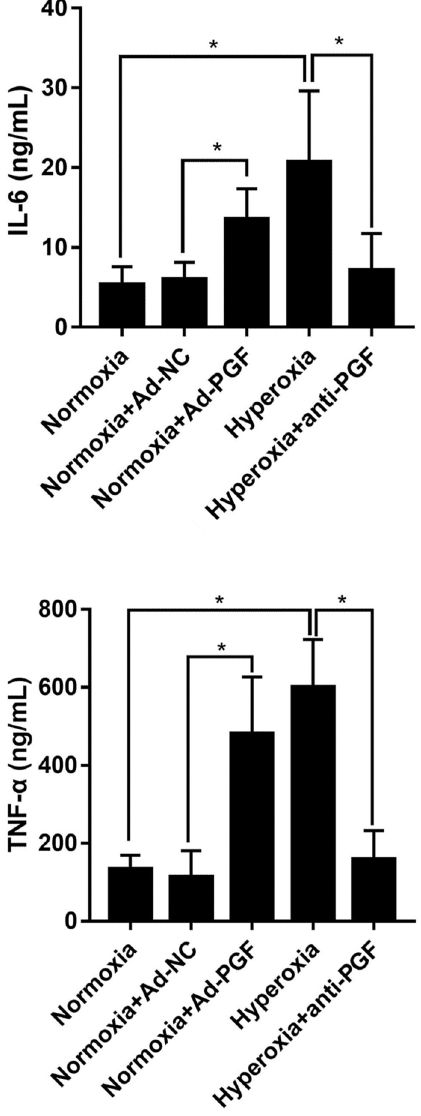
Figure 6. Interleukin (IL)-6 and tumor necrosis factor (TNF)- a levels in bronchoalveolar lavage fl uid from newborn rats of each indicated group (n=10) detected by ELISA. Data are reported as means ± SD. *P o 0.05 (ANOVA). PGF: placental growth factor; Ad-NC: adenovirus-negative control; Ad-PGF: adenovirus-pla- cental growth factor.